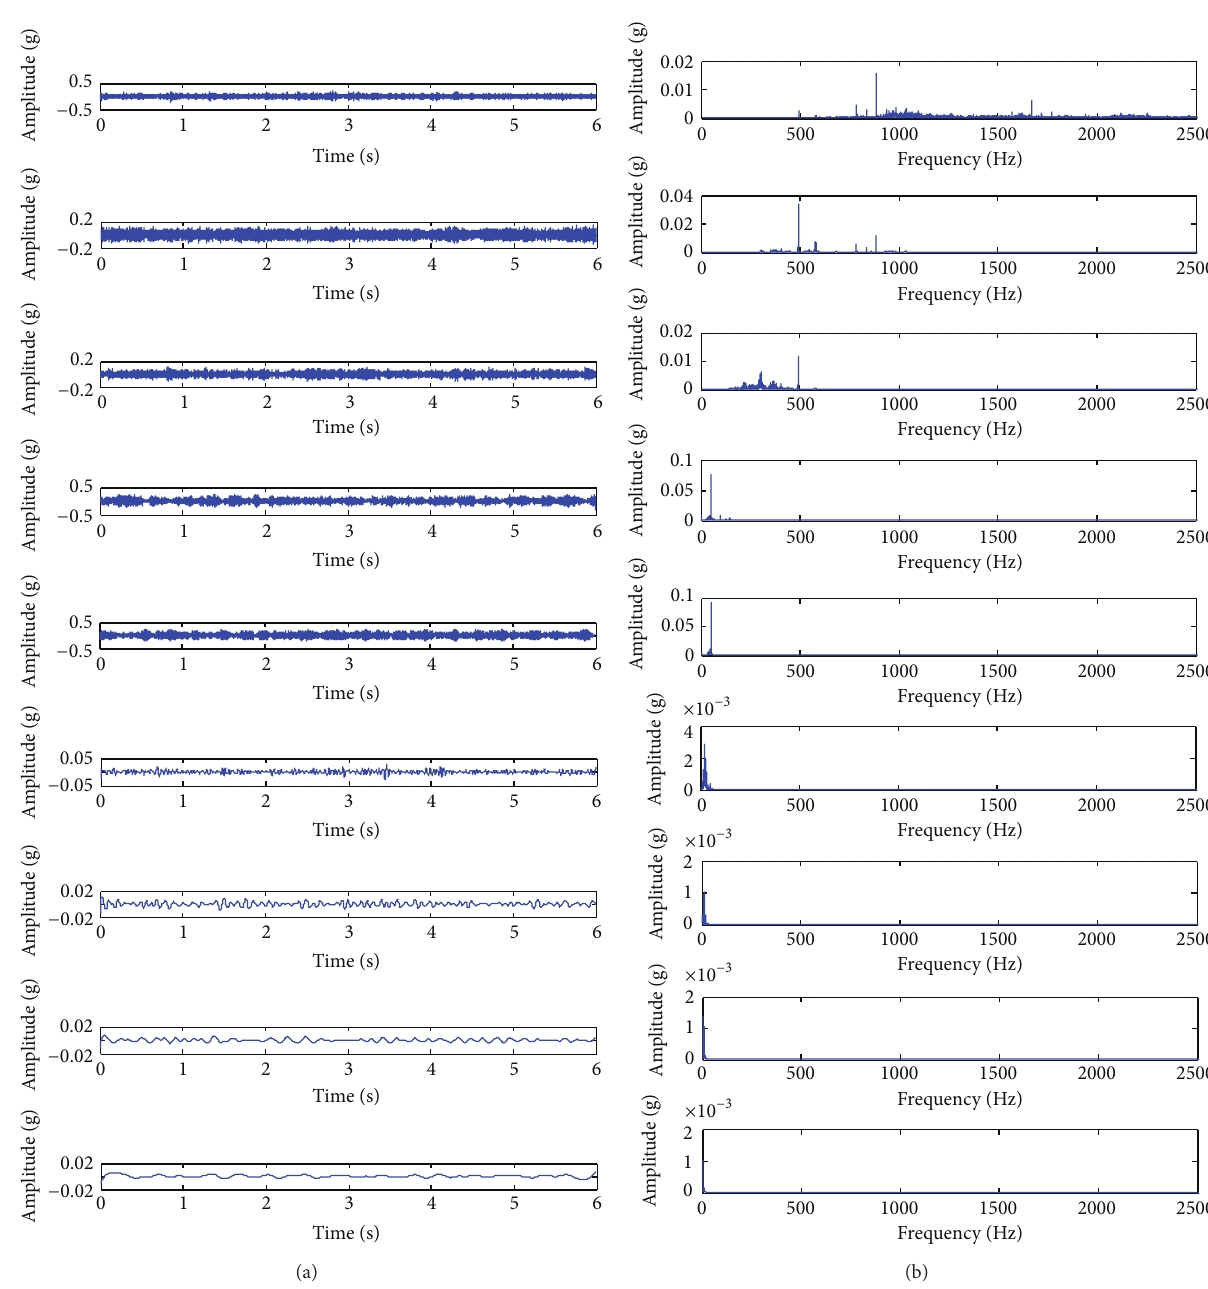
Figure 17: Results of the EEMD method under 32 mm crack condition: (a) IMFs and (b) frequency spectra of the IMFs. frequency analysis, we zoom in the frequency spectra with respect to the blade passing frequency and present the zoomed-in spectra in Figures 9, 11, and 13, respectively. It is obvious that the sideband frequency is not clear due to noise interference. This implies that it is unfeasible to detect the fault characteristics of blade crack from both the vibration signals and their frequency spectra. Further